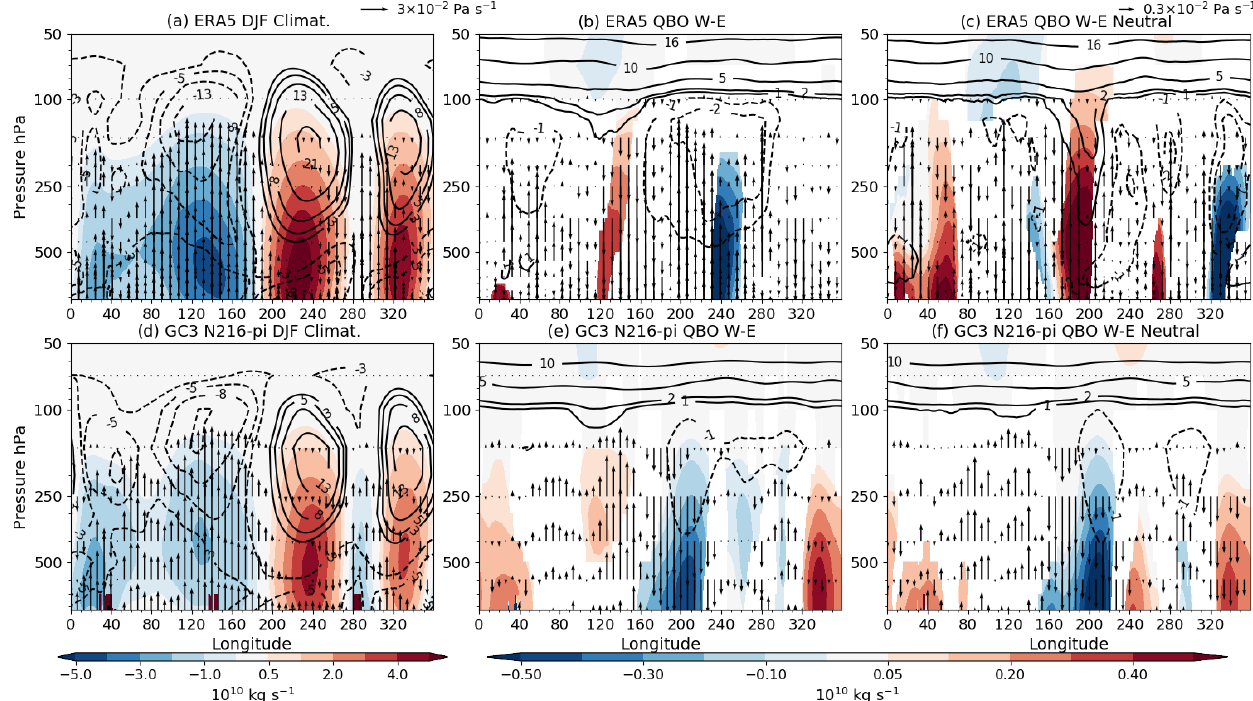
Figure 11. (a, d) Climatological mean state of the Walker circulation, depicted through the zonal streamfunction ( ψ ) in shading, the zonal wind (contours) and vertical velocity ( ω [Pas − 1 ], vectors) during the DJF season in (a) ERA5 and (b) N216-pi. (b, c, e, f) W–E composite differences, during DJF, for the same variables, and only statistically significant differences (95% confidence level) are shown. Panels (c) and (f) are as in panels (b) and (e) but considering ENSO-neutral periods only. Example vector sizes for ω are given in the top right corners of panels (a) and (c) . Note that the colour bar and vector sizes are different for the climatology plots (a, d) than for the anomaly